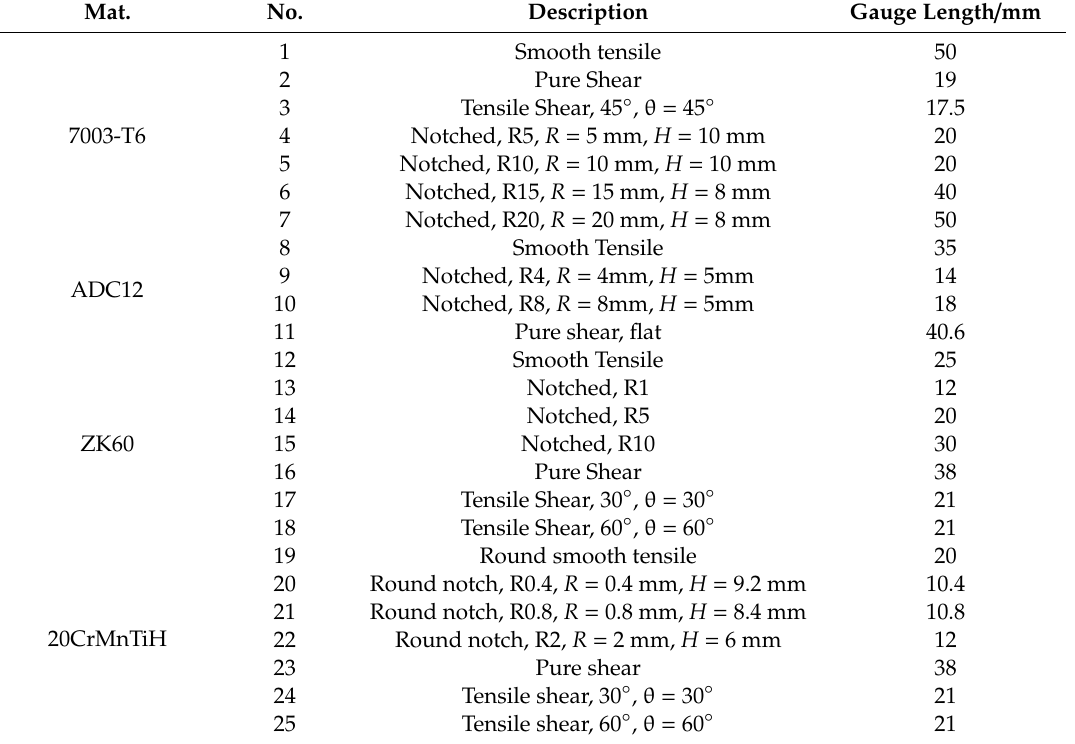
Figure 1. Schematic sketch of the specimen. specified value of R , H and θ can be found in Table 2. All dimensions are in mm. Table 2. Summary of experiments.